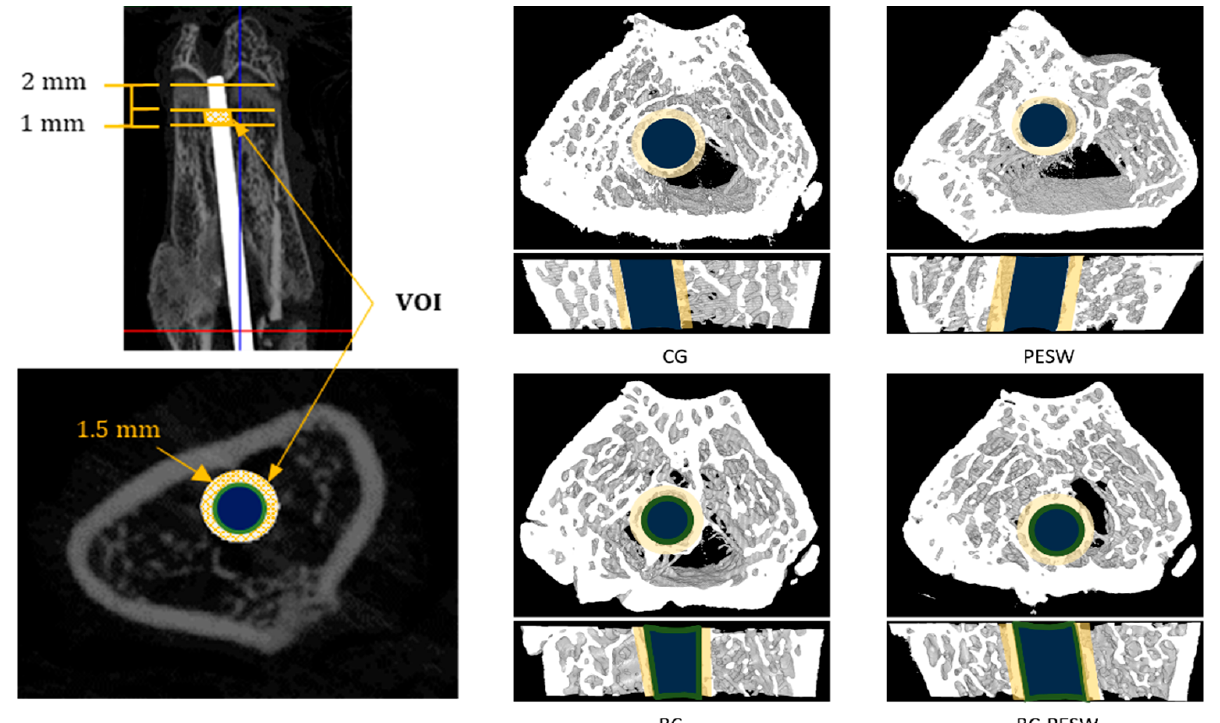
Figure 3. Three-dimensional reconstruction of the micro-CT images of the distal femur eight weeks after surgery. It gives examples of the cross-sections and 3D reconstructions of the implants and bone tissue around the implant. Dark blue—titanium implant; green—biomimetic composite (layer of 0.2 mm) around the titanium implant in the BC and BC-PESW groups; yellow—volume of interest (VOI) around the implant (0.3 mm); white and grey—bone.